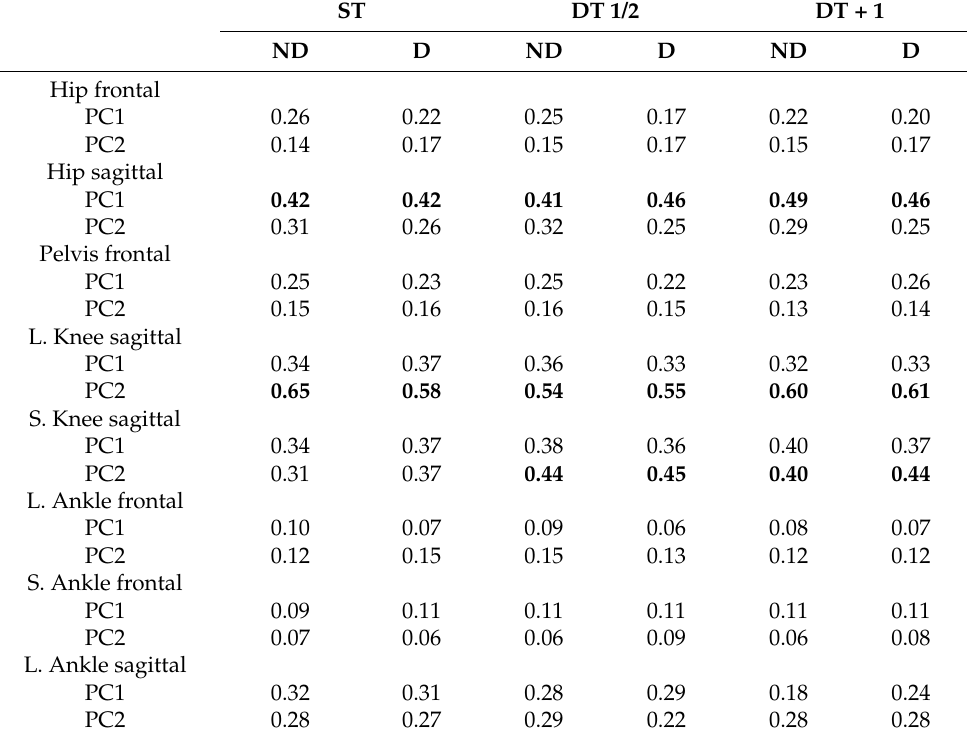
Table 2. Mean loadings presented in absolute values of the first two principal components. ST DT ST